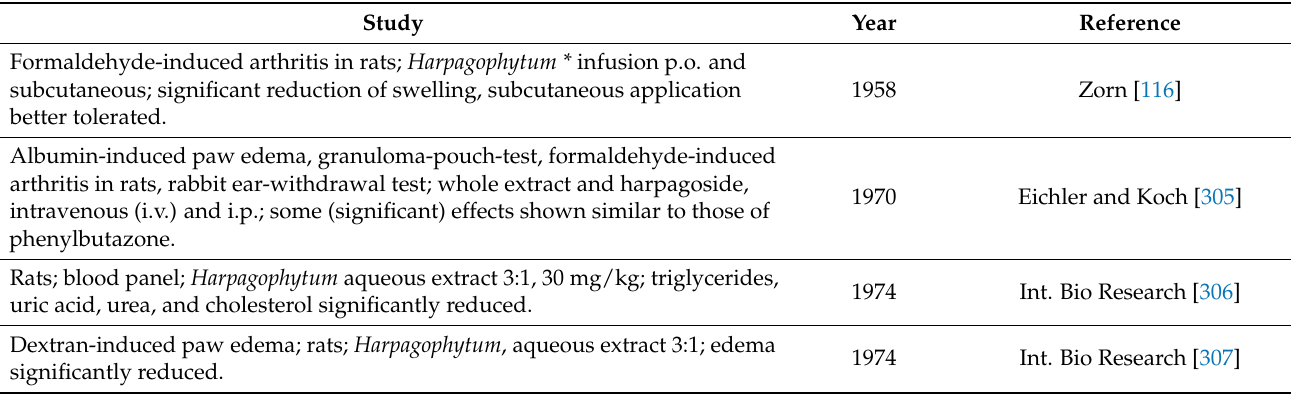
Table 5. In Vivo experiments regarding analgesic/antinociceptive and anti-inflammatory effects of devil’s claw preparations and